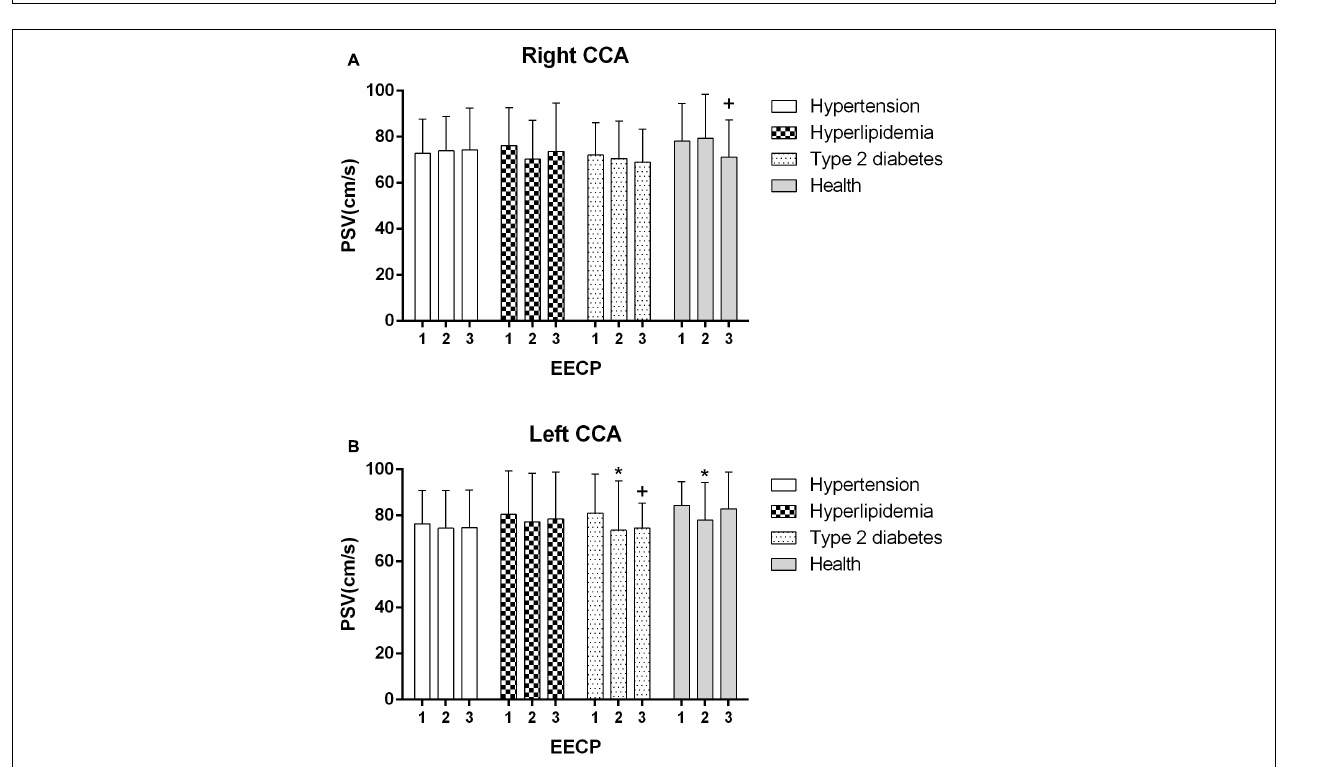
FIGURE 3 | Peak systolic velocity (PSV) in the right (A) and left (B) common carotid artery (CCA) in four groups before, during and after 45-min EECP. * P < 0.05 during EECP vs. pre-EECP; + P < 0.05 post-EECP vs. pre-EECP.